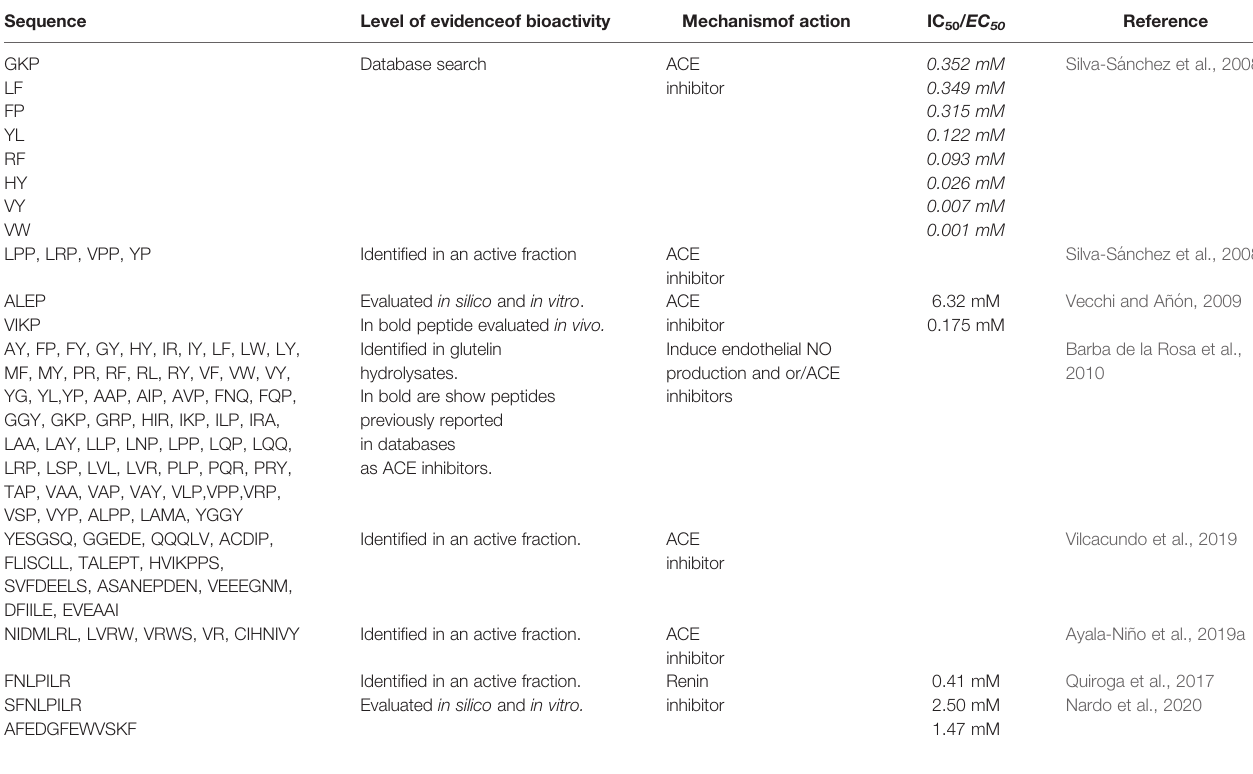
TABLE 1 | Sequences of bioactive peptides derived from Amaranth proteins with antihypertensive activity.